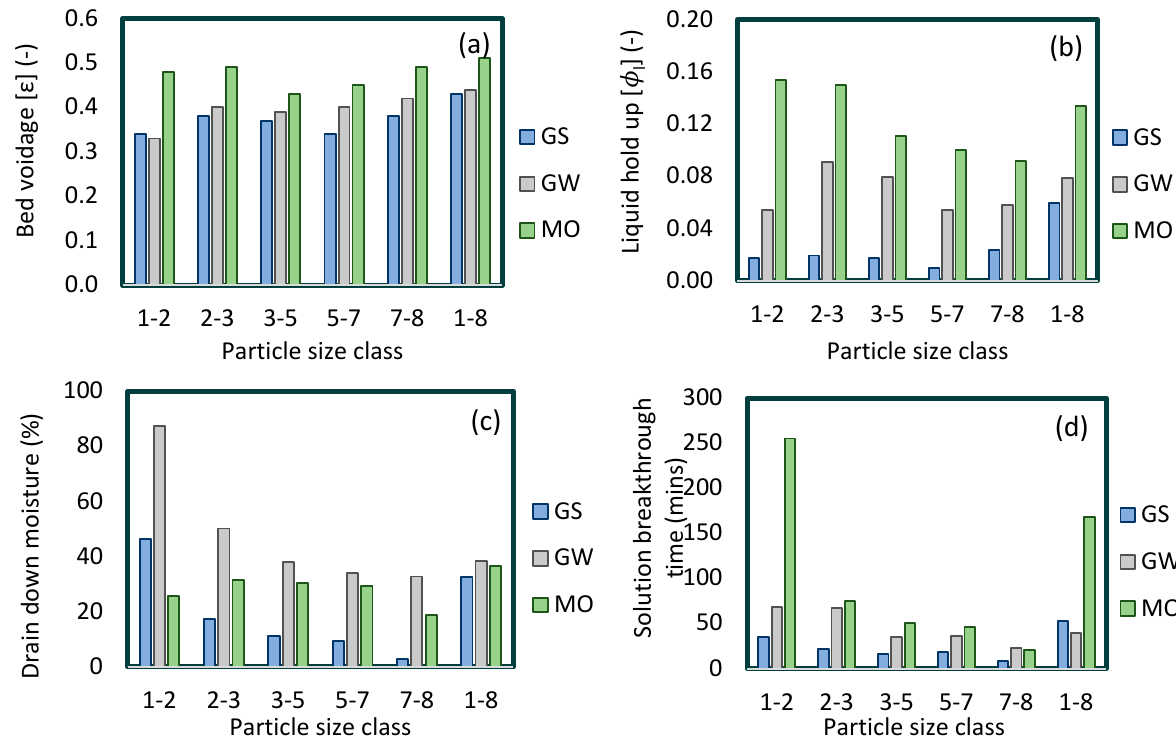
Figure 12. ( a ) Bed voidage, ( b ) total liquid hold-up, ( c ) 24-h drain-down moisture, and ( d ) solution breakthrough time characterisation data for beds composed of different size fractions of GS, GW, and MO.